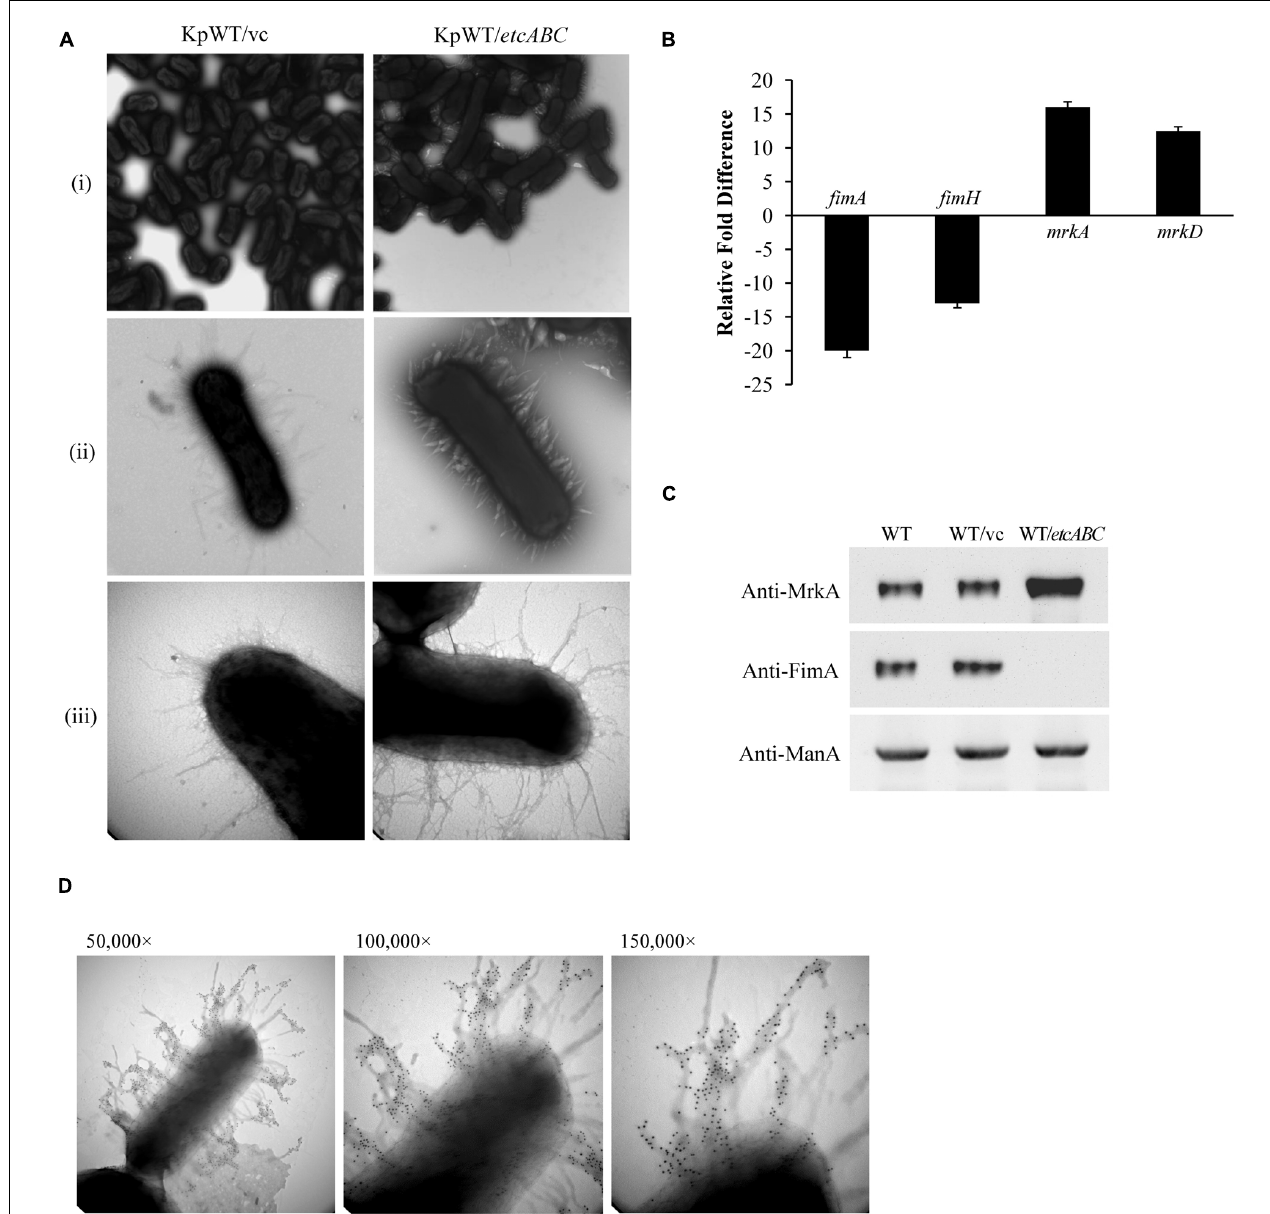
FIGURE 1 | Overexpression of etcABC enhanced type 3 fimbriae production in K. pneumoniae . (A) The representative TEM images of bacteria incubated in LB broth in three independent experiments. KpWT/vc: K. pneumoniae STU1 carrying pBSK-Gm as the vector control. KpWT/ etcABC : K. pneumoniae STU1 carrying pBSK::Gm:: etcABC to overexpress etcABC . The magnifications of the images are (i) 15,000 × , (ii) 50,000 × , and (iii) 100,000 × . (B) Transcriptional analysis of fimA , fimH , mrkA , and mrkD in KpWT/ etcABC and KpWT/vc by RT-qPCR. The 16S rRNA gene was used as the reference. Relative gene expressions means amount